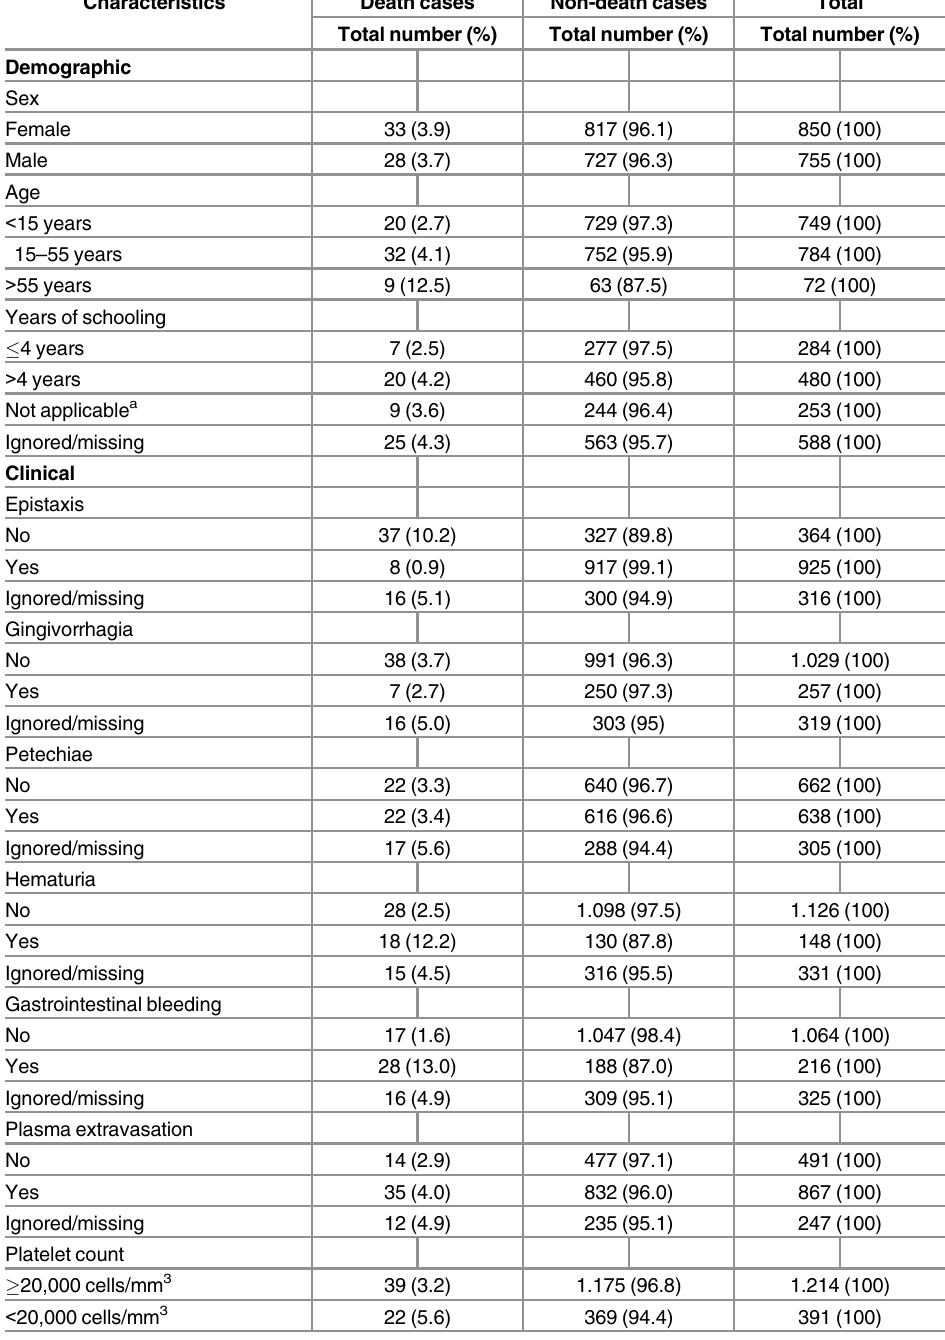
Table 1. Descriptive characteristics of severe dengue cases reported in the state of Amazonas, according to the occurrence of deaths in the period from 2001 to 2013.